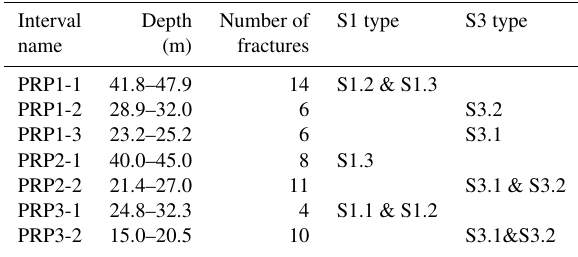
Table 2. Shear zones sampled by pressure monitoring